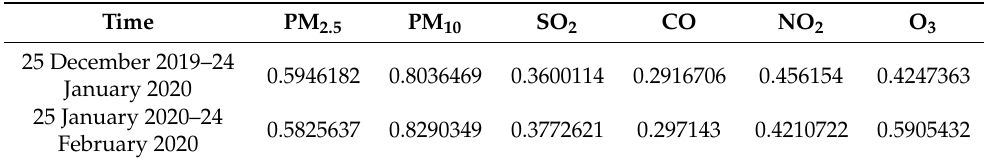
Table 3. The gray relational degree between pollutants and AQI between 25 December 2019 to 24